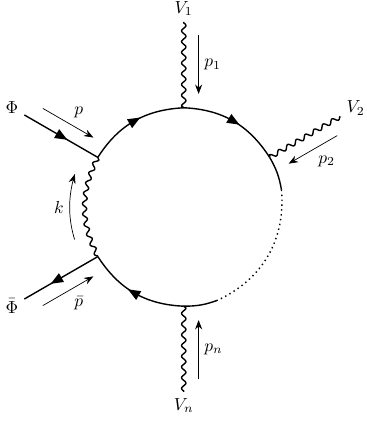
Figure 7 . One-loop Feynman supergraph contributing to the vertex with one external chiral, one antichiral and n vector superfields. Here p